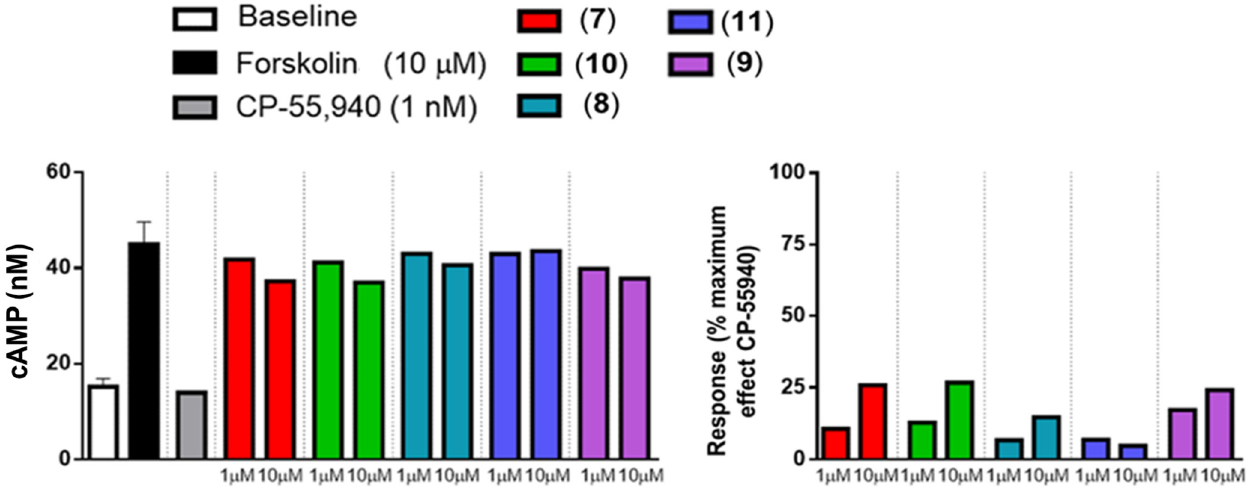
Figure 4. Effect of NSAID-pyrazolamides 7 – 11 on cyclic AMP intracellular concentration of CB 1 - transfected CHO cells. Data represent results from single replicates.